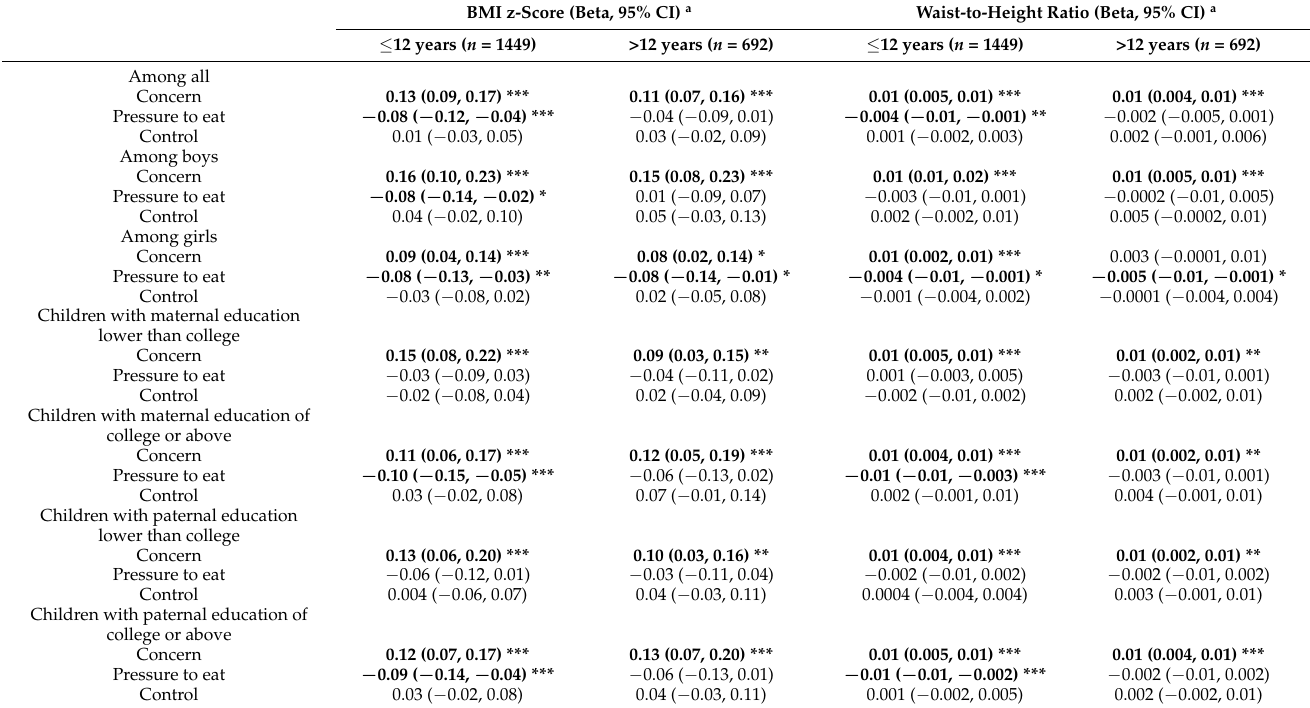
Table 3. Longitudinal associations between parental feeding practices and weight status of children, stratified by child age, child sex, and maternal and paternal educations—the Childhood Obesity Study in China